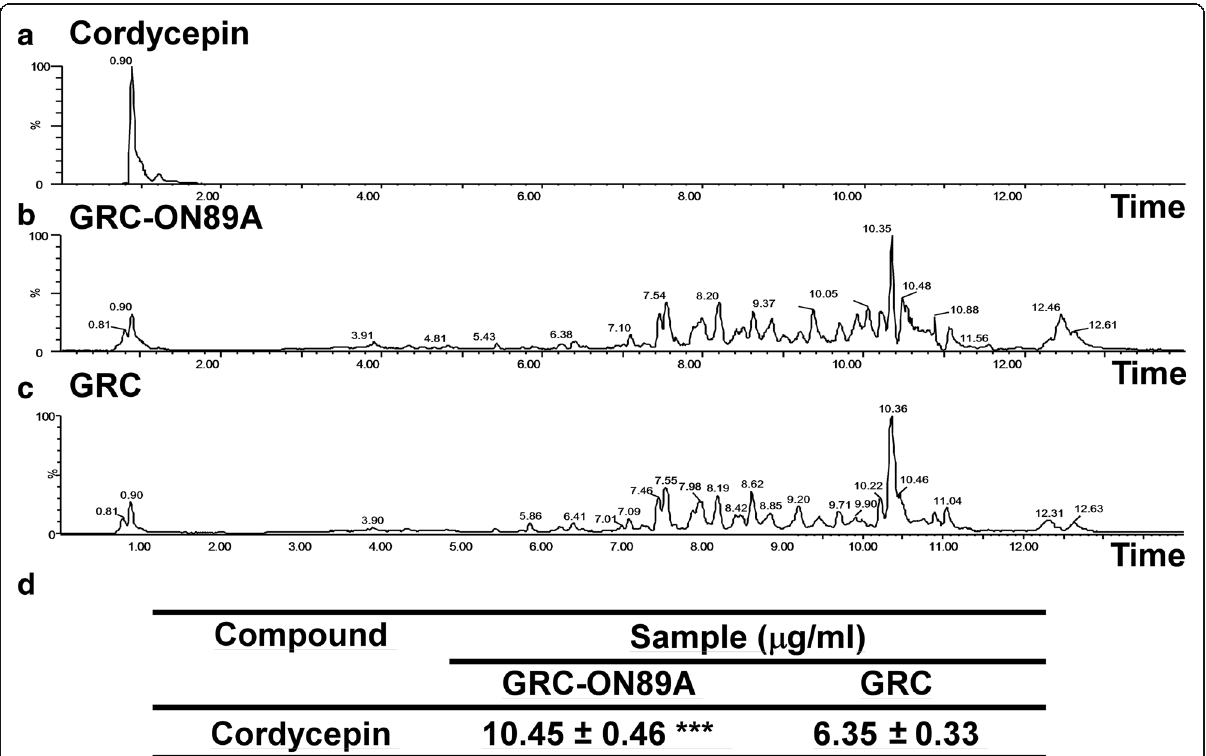
Fig. 6 Characterization of cordycepin content by UPLC-Q-TOF-MS. UPLC-MS chromatograms of ( a ) cordycepin, ( b ) GRC-ON89A and ( c ) GRC. d The quantitative analysis of cordycepin content in GRC before and after fermentation with ON89A. (*** = p < 0.005 vs. GRC, n > 3)